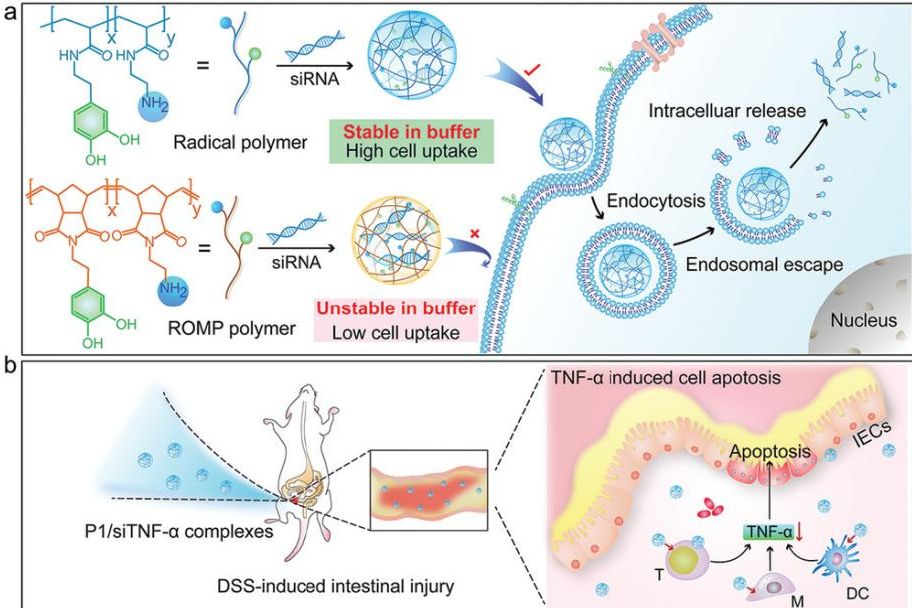
Figure 5. ( a ) Structures of the designed polymers and the proposed gene silencing mechanism in intracellular siRNA delivery. ( b ) A DSS-induced intestinal injury model was established to evaluate the gene knockdown efficiency of the lead radical polymer (P1)/siTNF- α complexes. The knockdown of TNF- α reduces DSS-induced intestinal epithelial damage. Reprinted with permission from Ref. [168]. 2021, John Wiley and Sons.